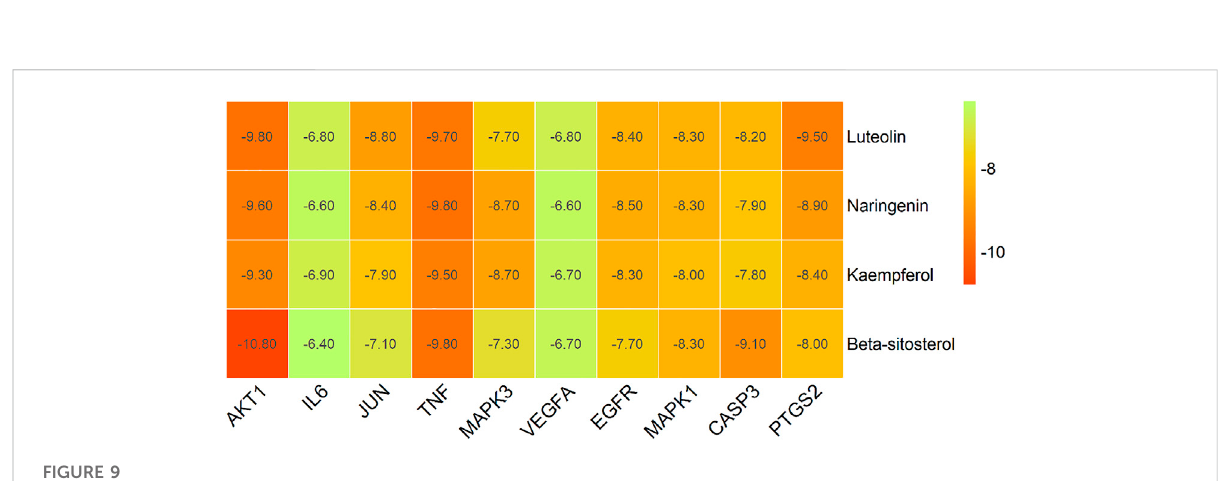
FIGURE 9 Heatmap of molecular docking